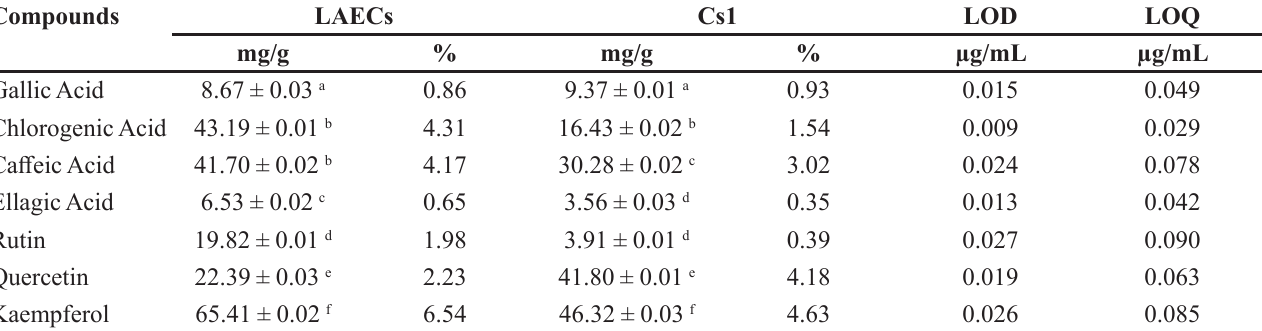
TABLE III - Composition of lyophilized aqueous extract of C. speciosa (LAECs) and raw ethanol extract (Cs1) Compounds